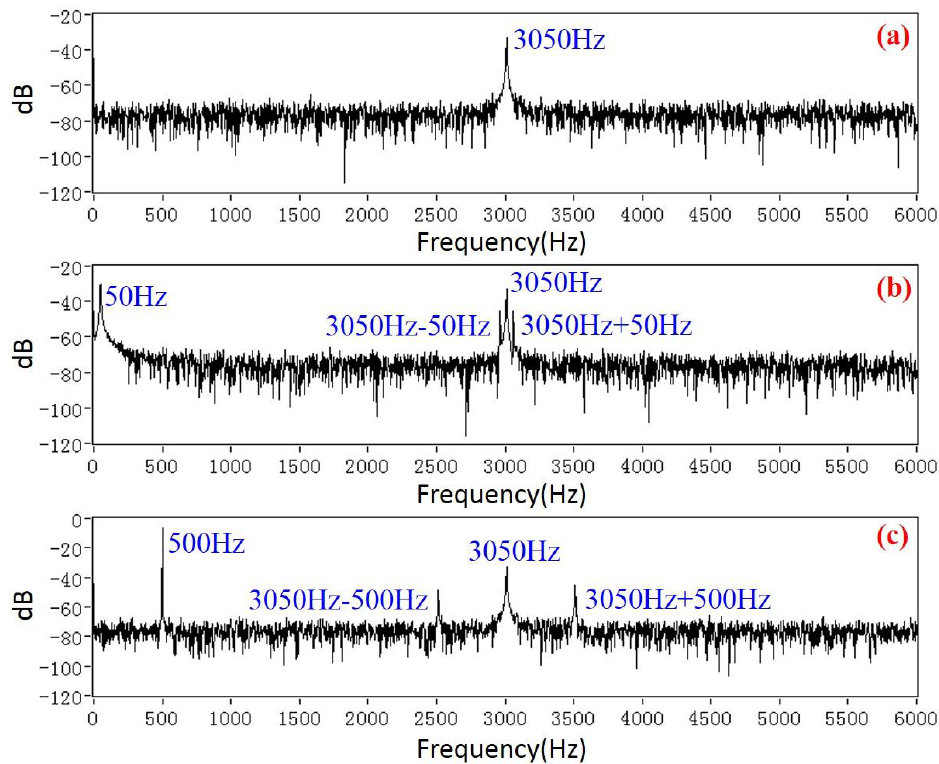
Figure 12. Spectrum of the microsensor output voltage: ( a ) under a DC electric field; ( b ) under a 50 Hz power frequency field; and ( c ) under a 500 Hz AC field.